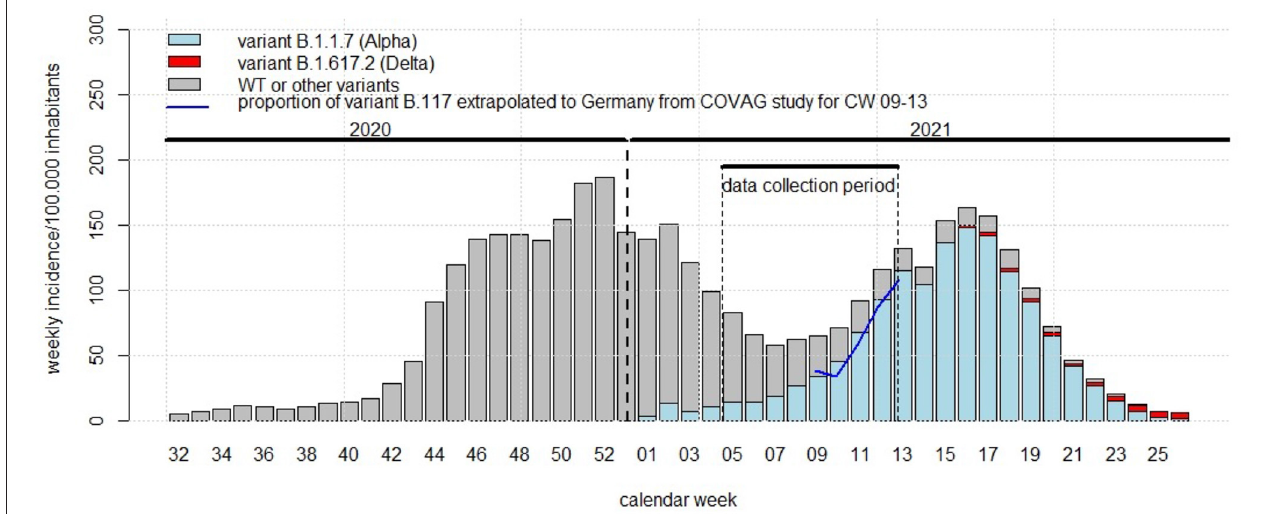
FIGURE 1 | Framing of the COVAG study (February 1-March 31) into the time course of the COVID-19 pandemic in Germany. Abszissa: calendar week within 2021; ordinate: Germany-wide weekly incidence rate of SARS-Cov-2 infections per 100,000 inhabitants; bars: weekly incidence rates of infections with SARS-CoV-2 variant B.1.1.7 (alpha, blue), variant B.1.617.2 (delta, red), and wild-type or other variants (NIM-type, gray). Blue solid line: proportion of variant B.1.1.7 (alpha) in the COVAG study extrapolated to